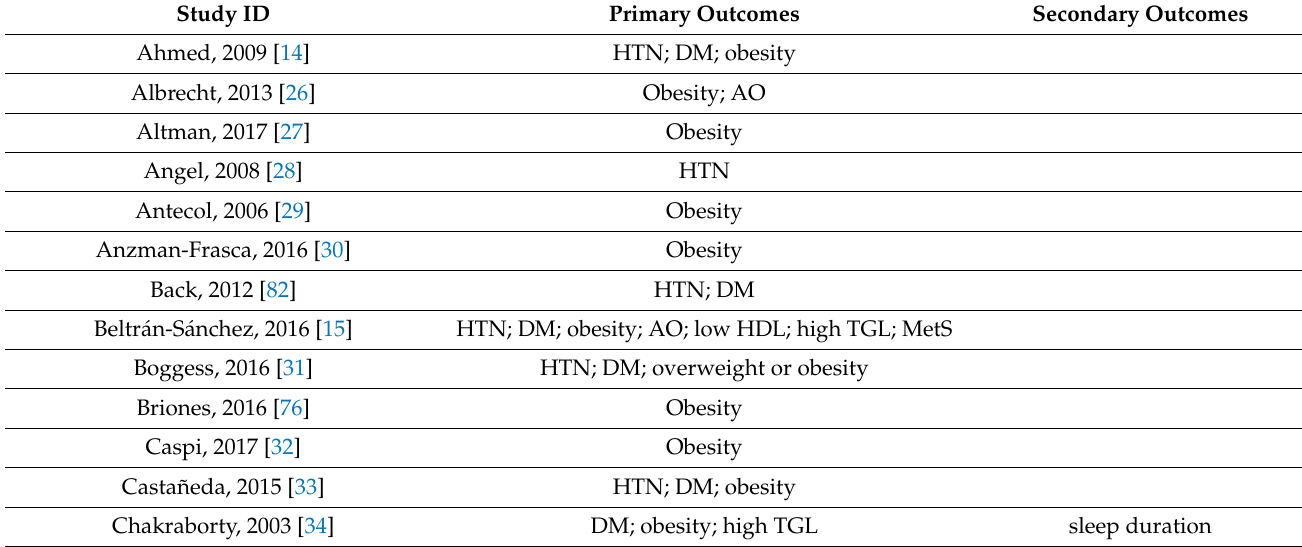
Table 6. Outcomes Assessed for the Latinos in the USA